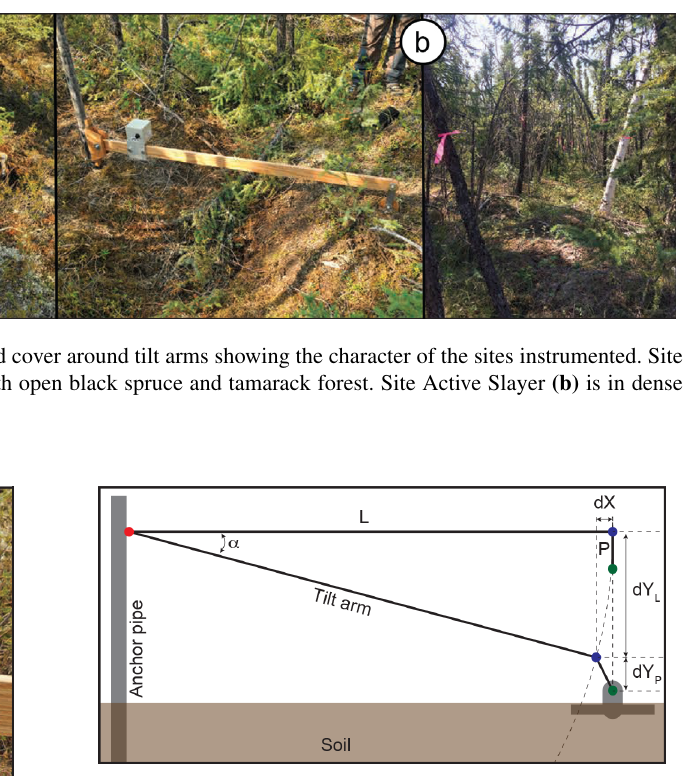
Figure 3. Geometry of the tilt arm defined by the lengths of the arm ( L ) and the double-pivot mechanism ( P ). The reference point on the anchor pipe is shown in red, the end of the tilt arm in blue and the ground attachment at the end of the double pivot in green. Only vertical soil movement is